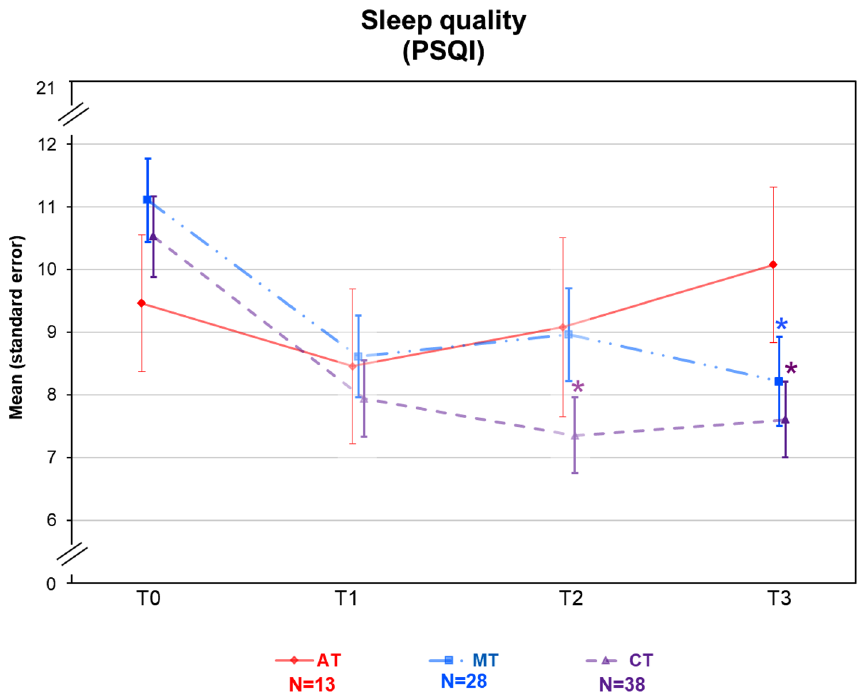
Figure 3. Course of the PSQI for the 3 study groups (aerobic training: red; multimodal therapy: blue; combination therapy: violet) over 4 years (n = 79), including after 10 weeks of intervention (T1) and 6 months later (T2) in frail color (n = 79). Colored asterisk indicates significant better sleep quality in MT and CT versus AT. PSQI Pittsburgh Sleep Quality Index, AT aerobic therapy, MT multimodal therapy, CT combination